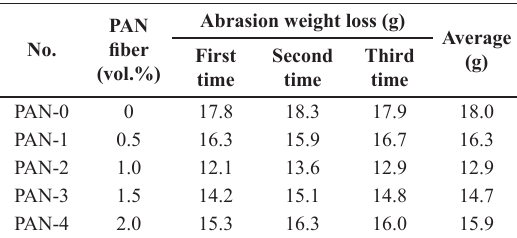
Table 5. Abrasion resistance performance of PAN fiber reinforced concrete.